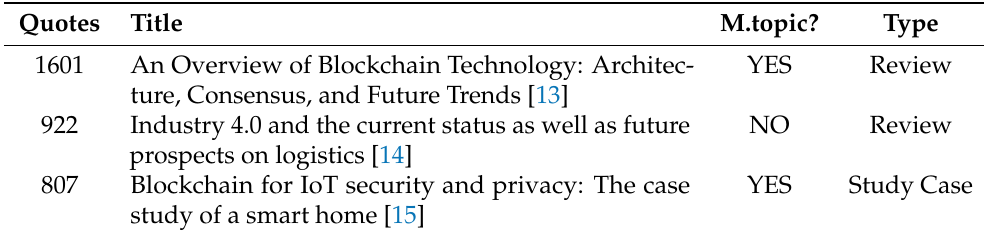
Table 4. Top 3 citations